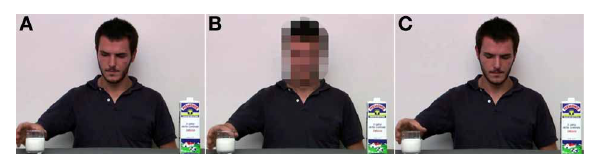
FIGURE 3 | Final frames for videos in Experiment 2. In the Gaze Action video (A) the actor turned the head to look toward and reached for the glass. In the Blurred Gaze Action video (B) the actor turned his head, looked toward and reached for the glass but participant’s access to the actor’s gaze direction was prevented by blurring the actor’s face. In the Ambiguous Gaze Action video (C) , the actor reached the glass without looking toward it.